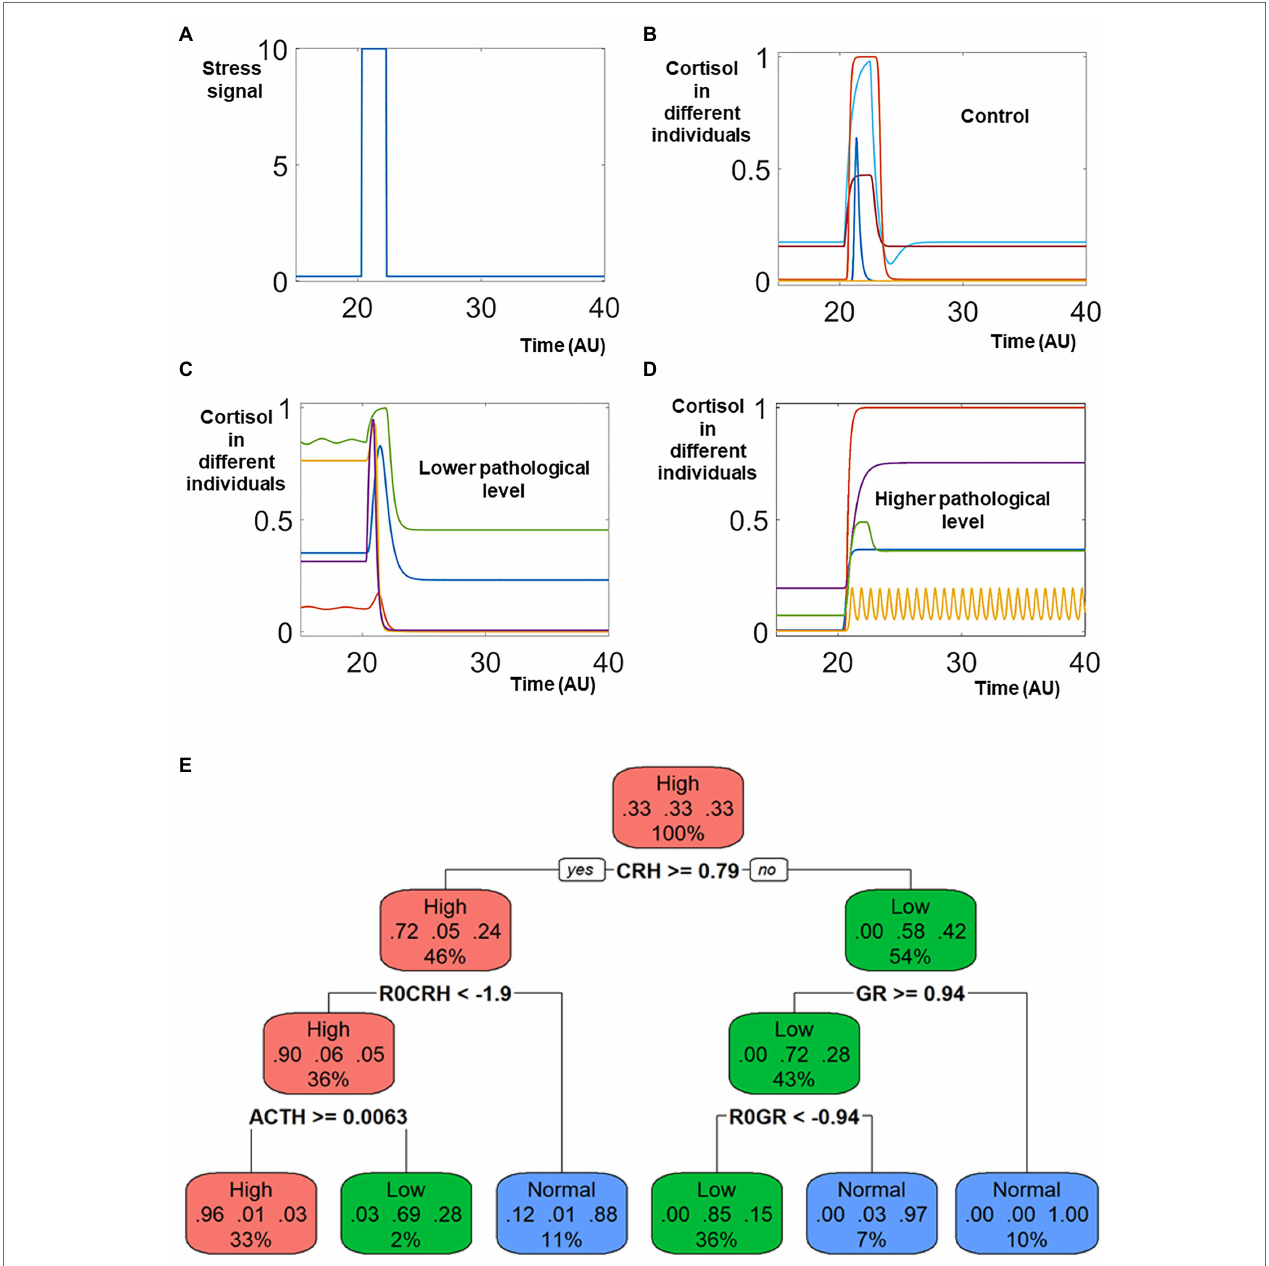
FIGURE 2 | Sampling the heterogenous response triggered by stress signal. Identical model structure and different values of all parameters are used to simulate the heterogenous response to stress signal. In response to a transient elevation of the stress signal (around time 20, A ), the cortisol levels in the control population (B) returned to normal levels after transient elevation, representing the healthy population who do not develop neuron endocrine disorder after stress. On the contrary, the levels of cortisol decreased and were sustained lower in patient populations who were characterized by lower pathological levels of cortisol (C) . The cortisol levels were elevated and remained higher in patients whose pathological cortisol levels were higher after stress (D) . (E) Classification Tree. The different colors of different nodes indicate the types of dominant populations: red nodes indicates that most individual in the node had higher cortisol after stress; green nodes indicates that most individuals were characterized by lower levels of cortisol; blue nodes indicate the ones with most individuals from the control population. In the top node, individuals from these three populations were of identical number, and the node is labeled